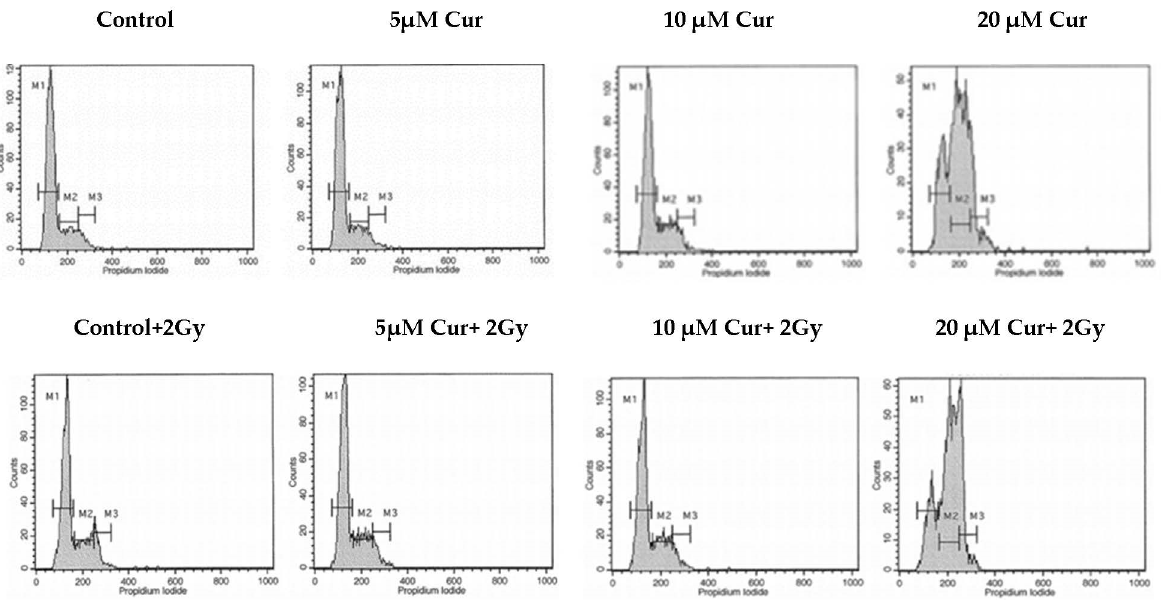
Figure 7. Histogram representation of cell-cycle distribution in U87 cells after treatment with increasing curcumin concen- trations. Cells (10 4 ) were seeded in 24-well plates and after 24 h were exposed to different curcumin concentrations; 2 h later, the plates were irradiated with 2 Gy. After 72 h, the cells were stained with propidium iodide and the DNA content was observed.